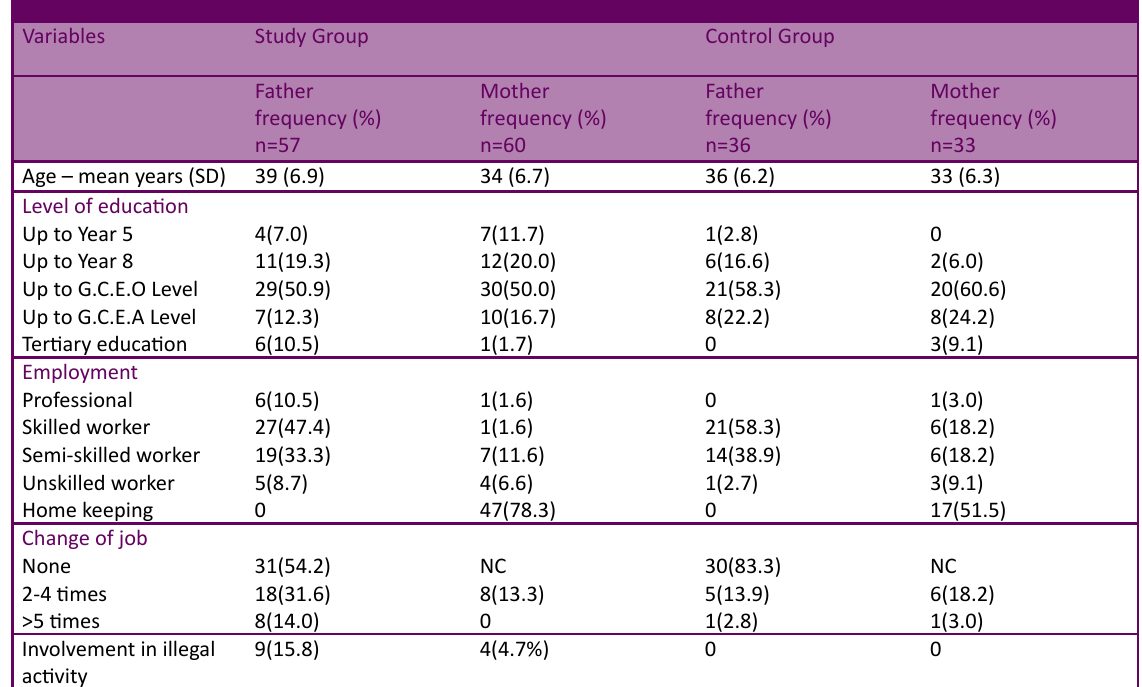
Table 1 – Comparison of socio-demographic data of study and control groups